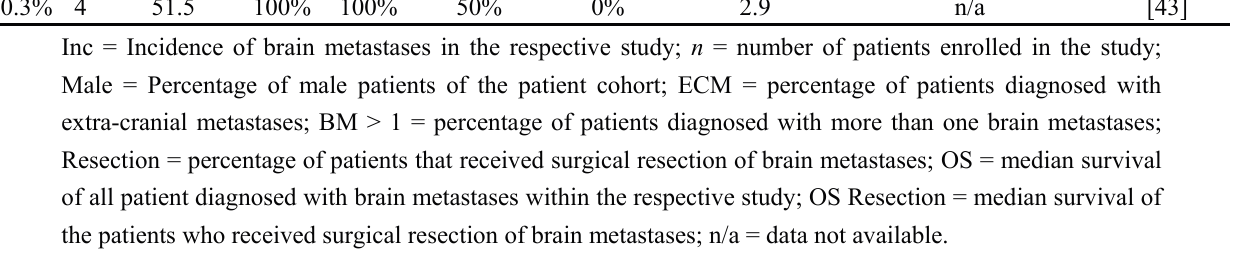
Table 5. Clinical studies analyzing characteristics and survival of patients diagnosed with brain metastases originating from colorectal